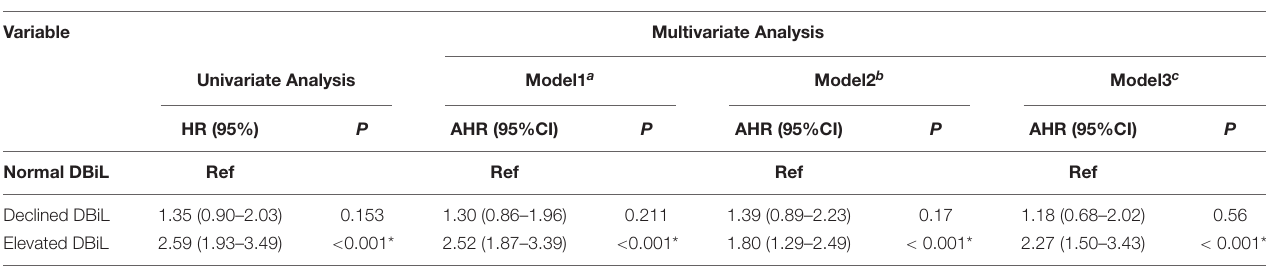
TABLE 4 | Cox proportional hazards regression for death among 337 COVID-19 severe/critically ill patients with various DBiL levels.